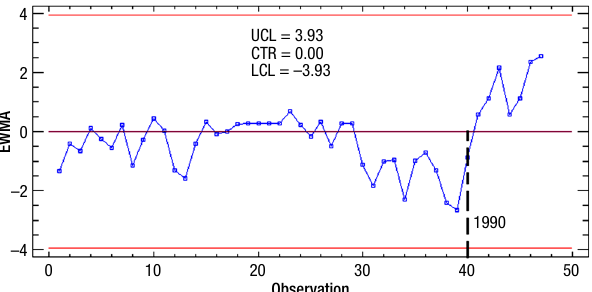
Fig. 19b. EWMA chart for Residuals for time series of annual Argentinian GDP